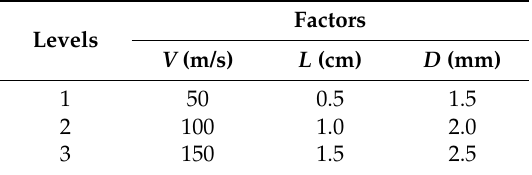
Table 2. Factors and levels of the orthogonal experimental design.